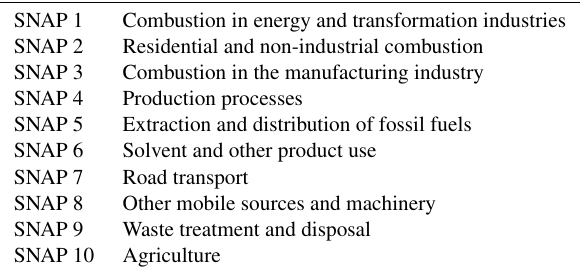
Table 1. SNAP source sectors (Eurostat,